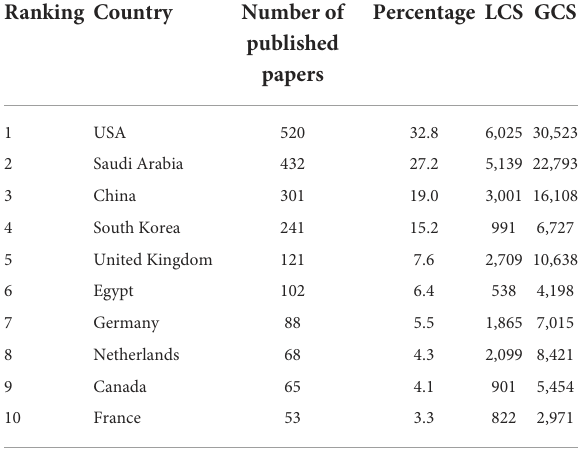
Figure 4, Zaid A. Memish had the strongest collaboration with Jaffar A. Al-Tawfiq; both the authors are from Saudi